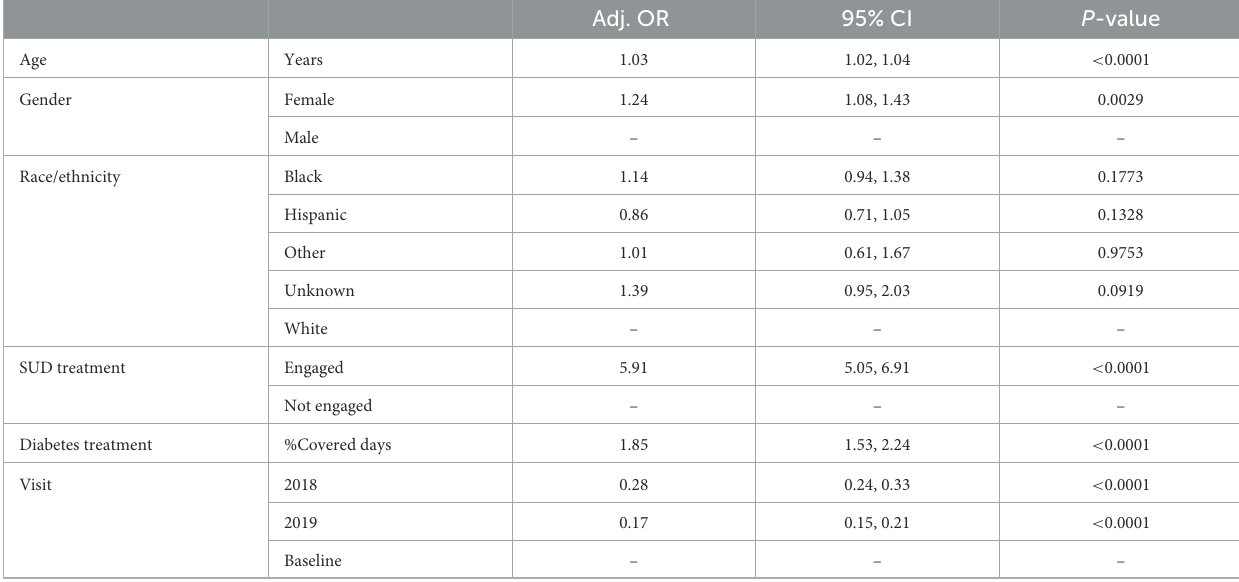
TABLE 3 Generalized linear mixed models (GLMM) results: engagement in substance use disorder treatment as a predictor of HbA1c control 2016–2019 among HCN patients with type 2 diabetes and SUD. Adj. OR 95%